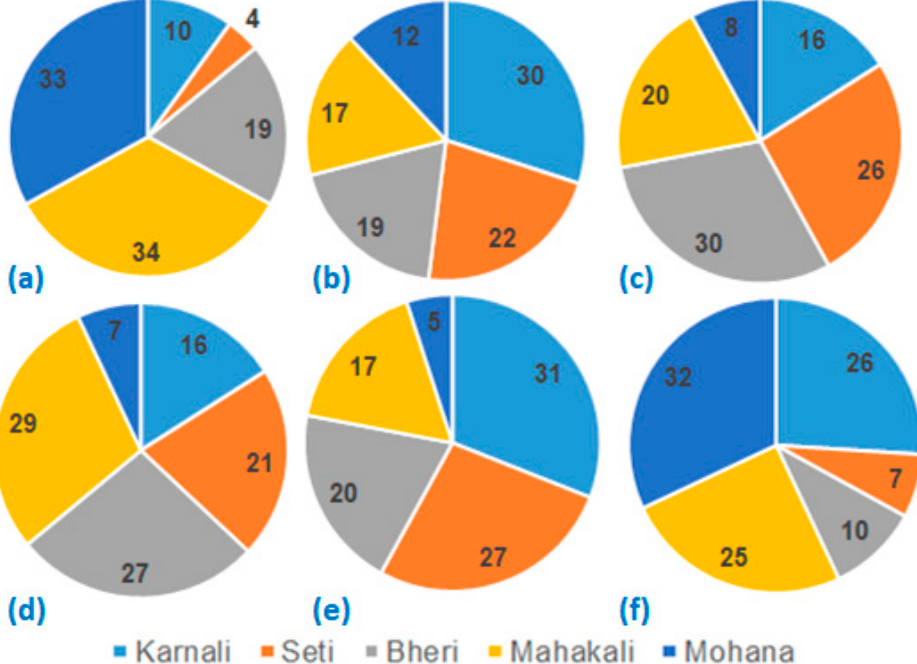
Figure 5. Percentage of respondents perceiving different types of shocks in the last five years disaggregated by sub-basins: ( a ) flood; ( b ) drought; ( c ) untimely rainfall; ( d ) irregular weather; ( e ) hailstorm; and ( f ) serious pest damage to crops.